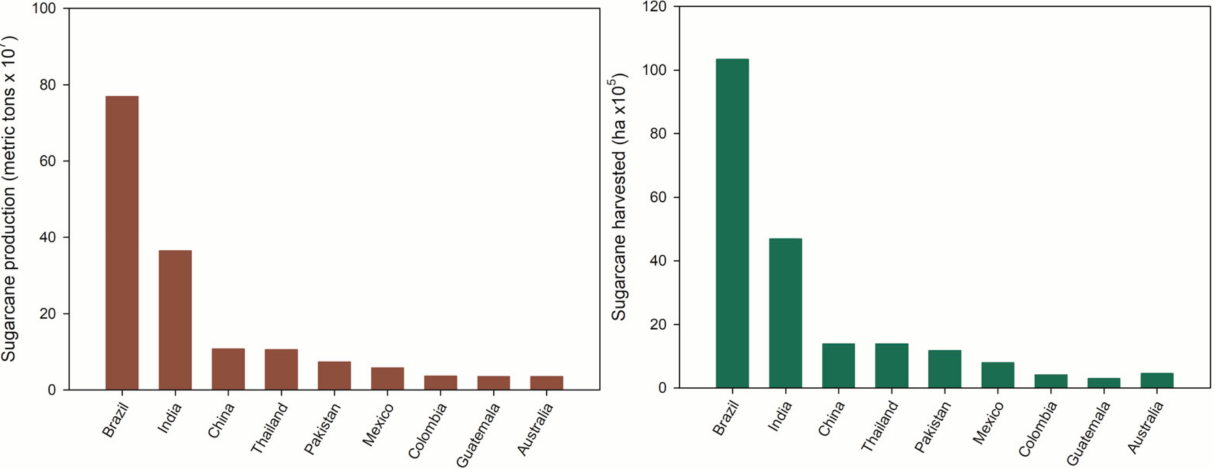
Figure 2. Global sugarcane